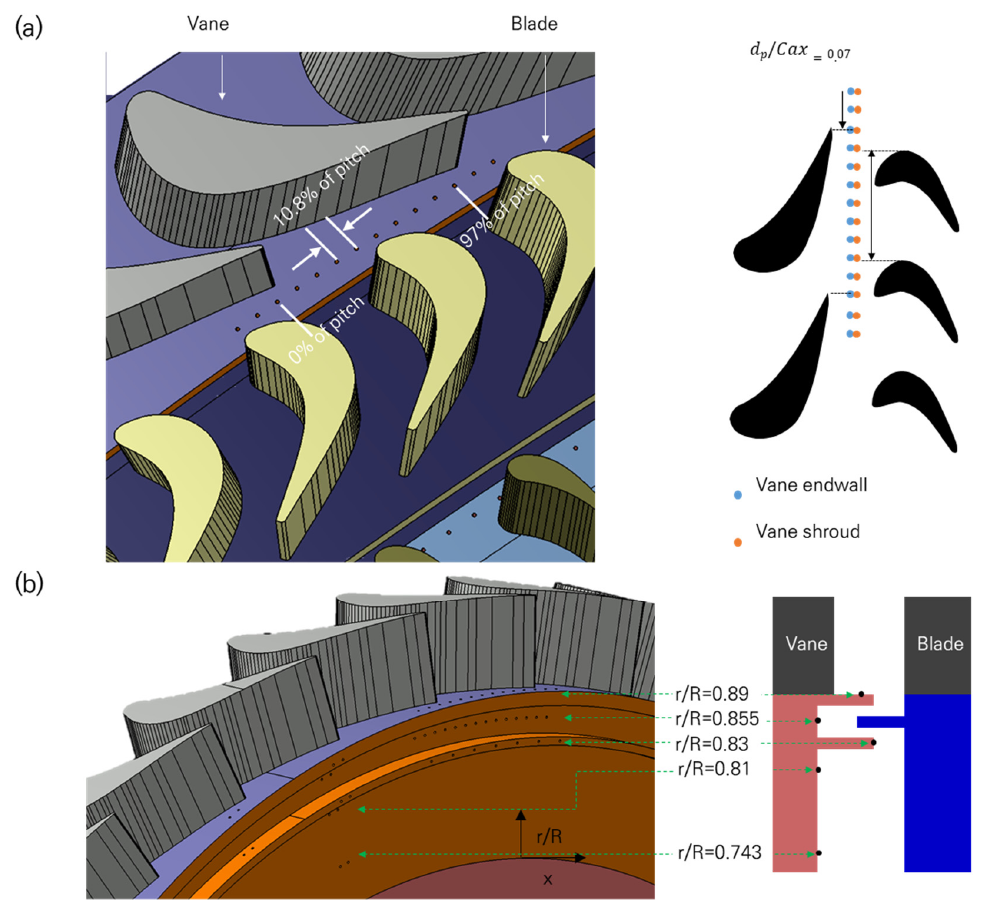
Figure 3. ( a ) Pressure measurement tap locations on turbine endwall and shroud, and ( b ) pressure and CO 2 measurement tap locations on rim seal